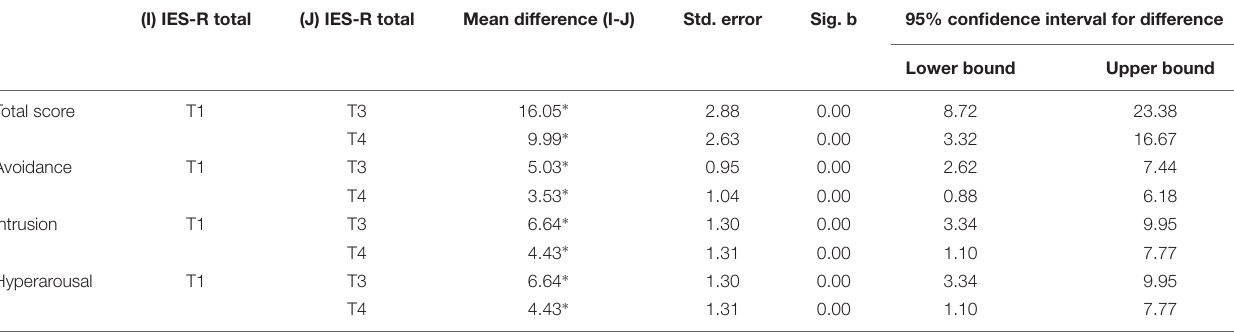
TABLE 3 | Impact of Event Scale-Revised score comparisons.